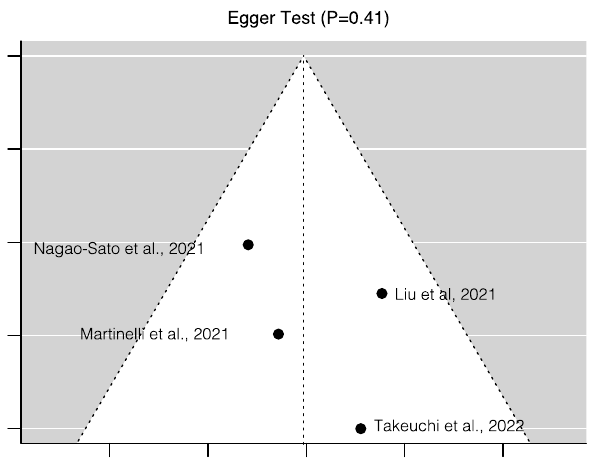
Figure 4. Risk of publication bias assessment for the four studies included in the meta-analysis– Liu et al. (2021) [50], Martinelli et al. (2021) [51], Nagao Sato et al. (2021) [52], and Takeuchi et al. (2022) [53], to examine the correlation between reflection spectroscopy-assessed skin carotenoid score with fruit and vegetable consumption in children.